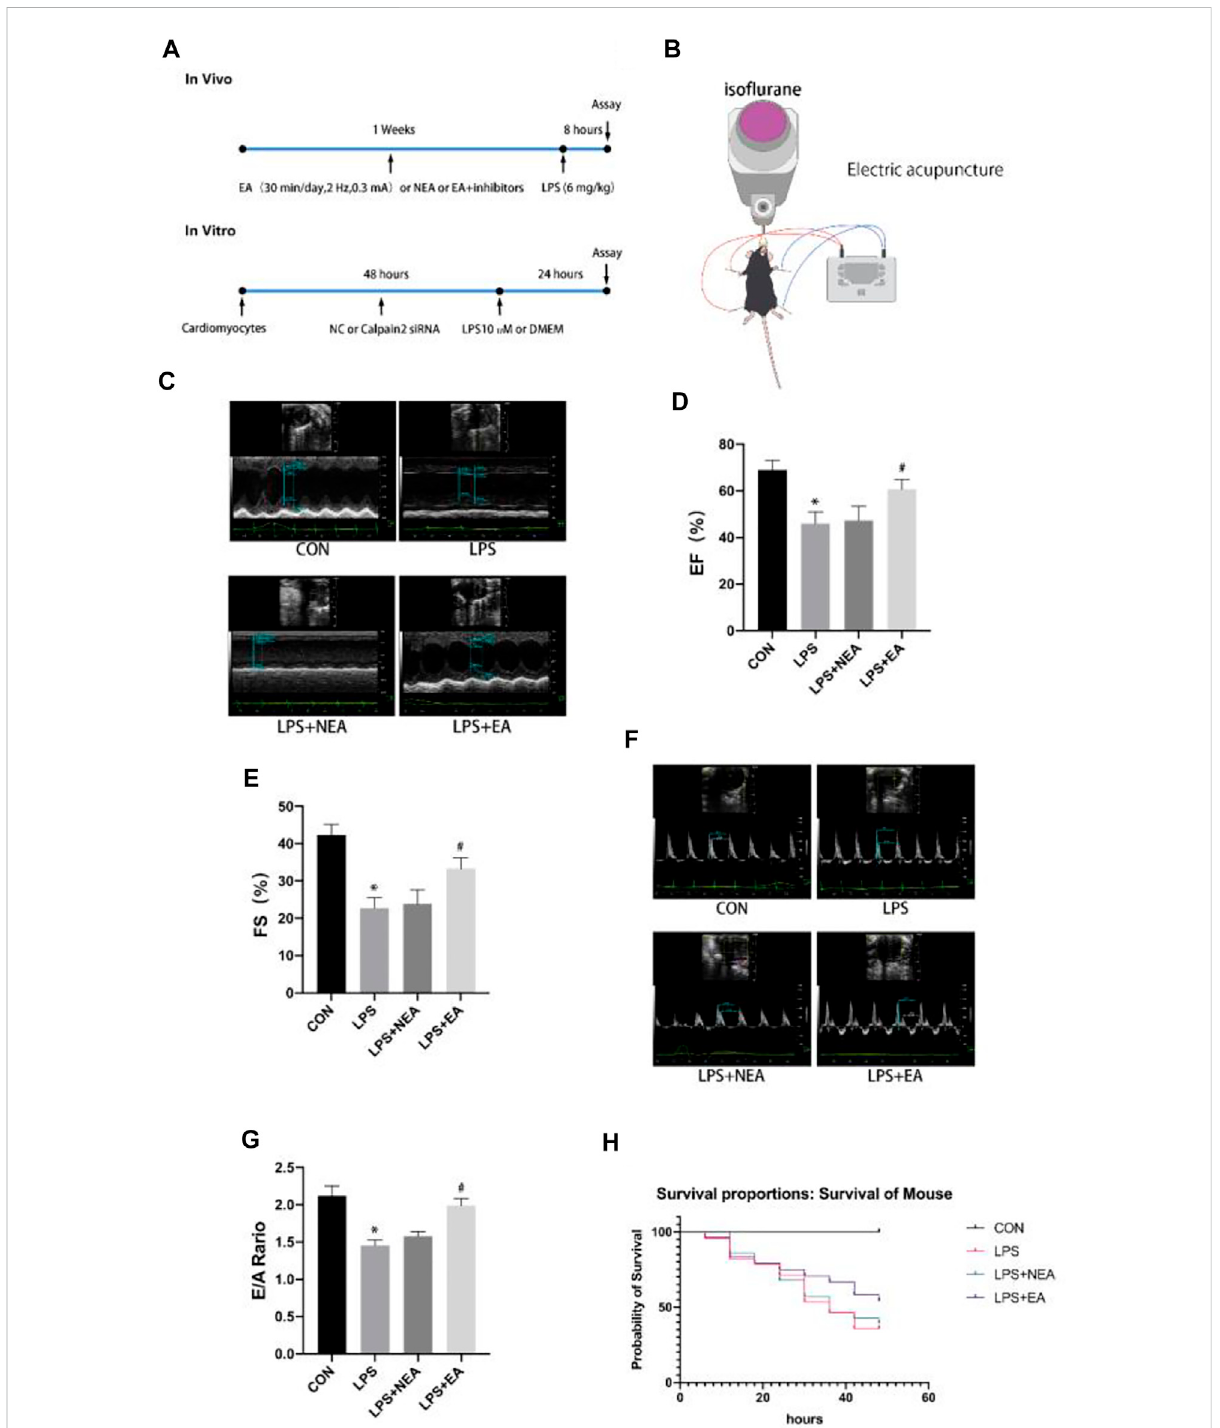
FIGURE 1 EA pre-treatment attenuates LPS-induced cardiac dysfunction. (A) Schematic diagram of the experimental protocols. (B) Schematic representation of EA treatment in mice. NEA group was the same current loop but the acupoints at digits from corresponding limbs. (C) Representative images of M-mode echocardiography in the LPS + EA pre-treatment group. (D) Ejection fraction (EF). (E) Fractional shortening (FS). (F) Representative mitral E/A image on Doppler echocardiography. (G) E/A ratio. N = 4 per group. EA, electroacupuncture; NEA, EA in non- acupoint; LPS, lipopolysaccharide. * p < 0.05 vs. control group, # p < 0.05 vs. LPS group. (H) Survival curve during 48 h,N = 8 in the CON group,N = 28 in the LPS group, N = 28 in the LPS + NEA group, and N = 24 in the LPS + EA